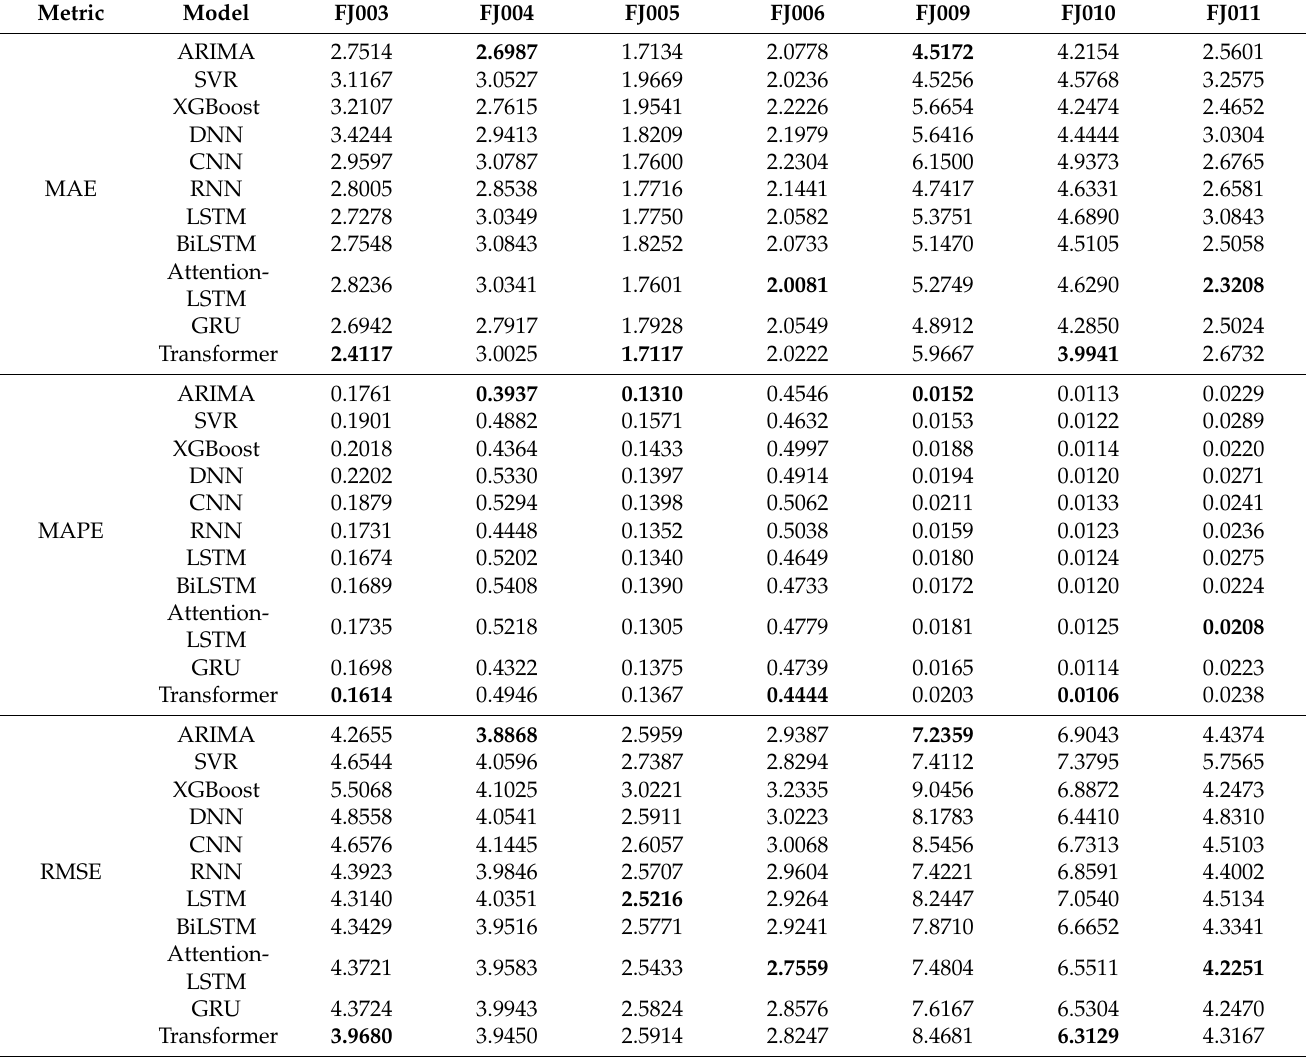
Table 4. Prediction accuracies of all